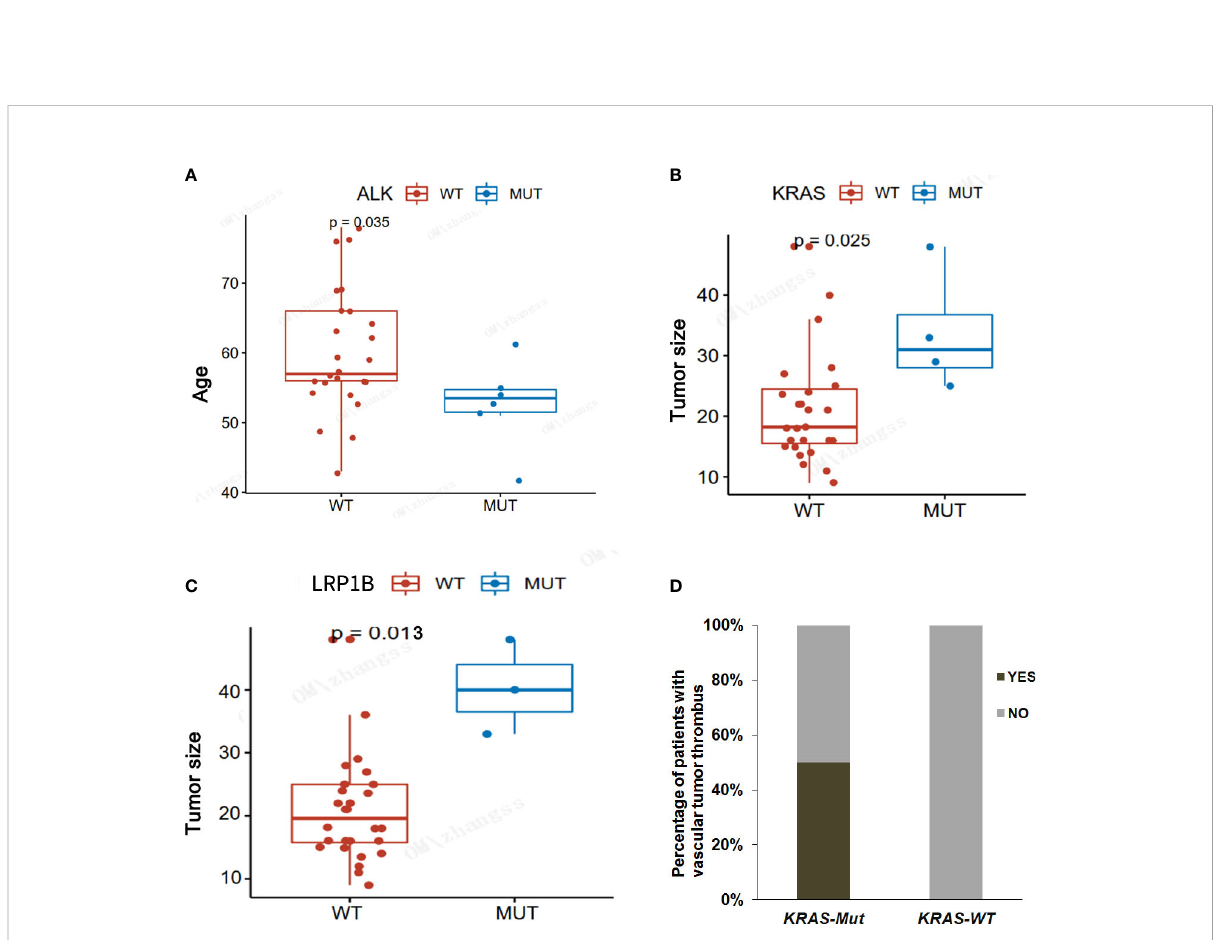
FIGURE 4 Correlation analyses between major driver gene alterations and clinicopathological characteristics in LAMPC patients. (A) A correlation analysis between ALK mutation and age. (B) A correlation analysis between KRAS mutation and tumor size. (C) A correlation analysis between LRBP1 mutation and tumor size. (D) A correlation analysis between KRAS mutation and vascular tumor thrombus. p < 0.05 was considered statistically signi fi cant, and p < 0.01 was considered more statistically signi fi